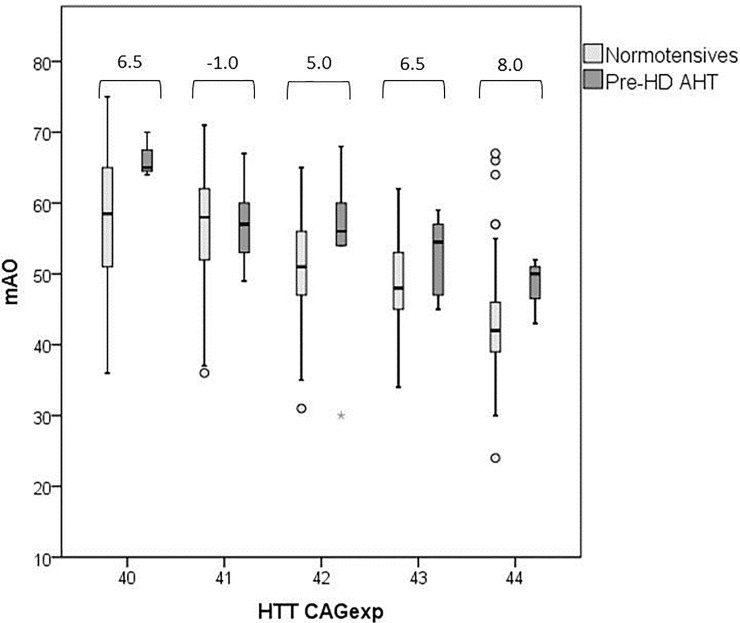
Variance in mAO for each CAGexp allele (40–44 range) in normotensives and in pre-HD AHT patients.Numbers above the square brackets are the difference in median years between Pre-HD AHT and normotensives for each CAGexp allele.